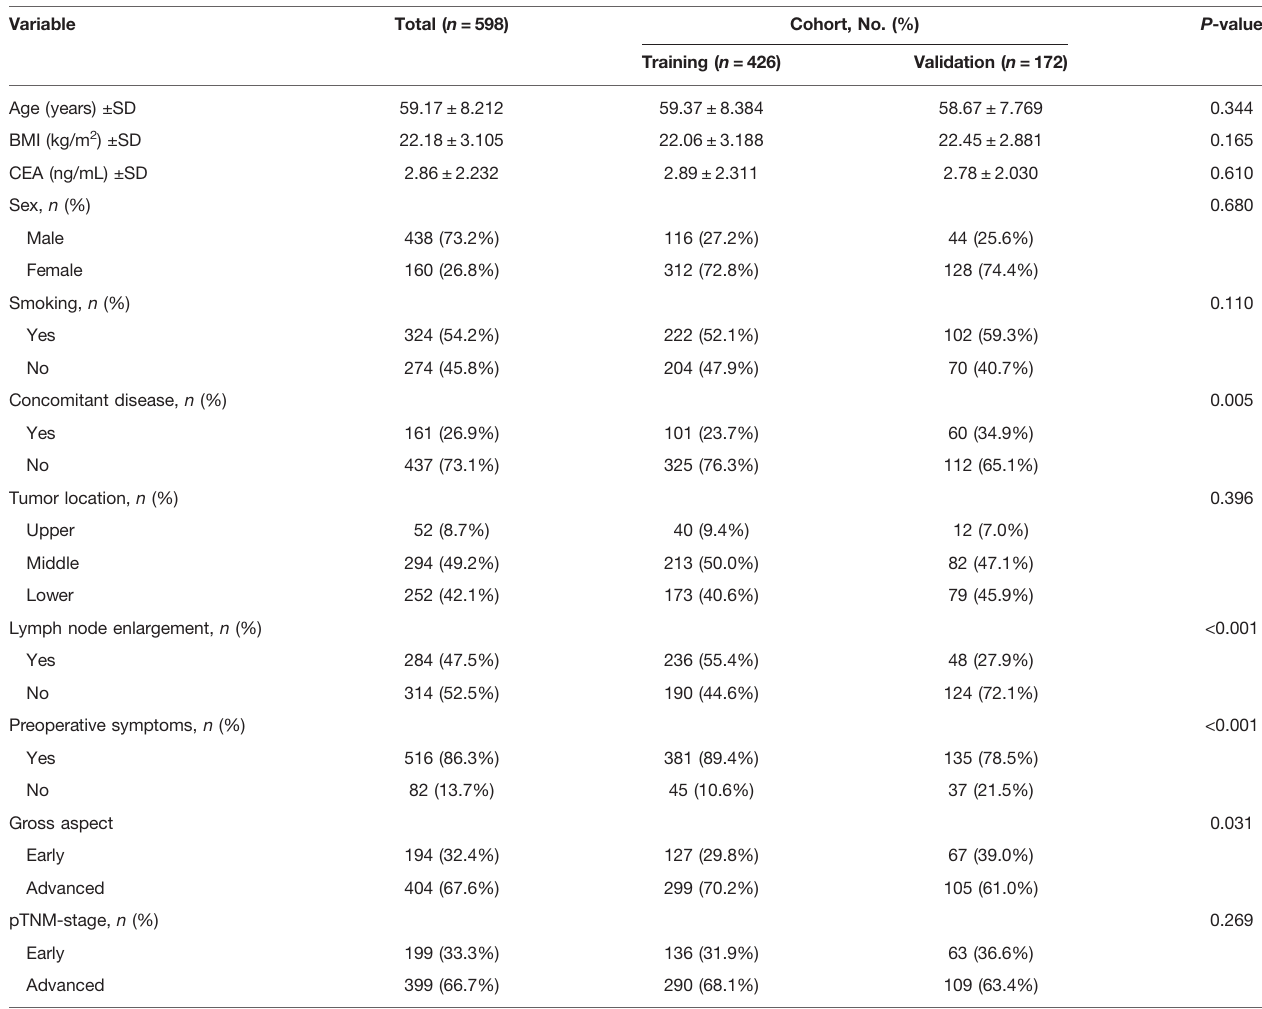
TABLE 3 | Participant